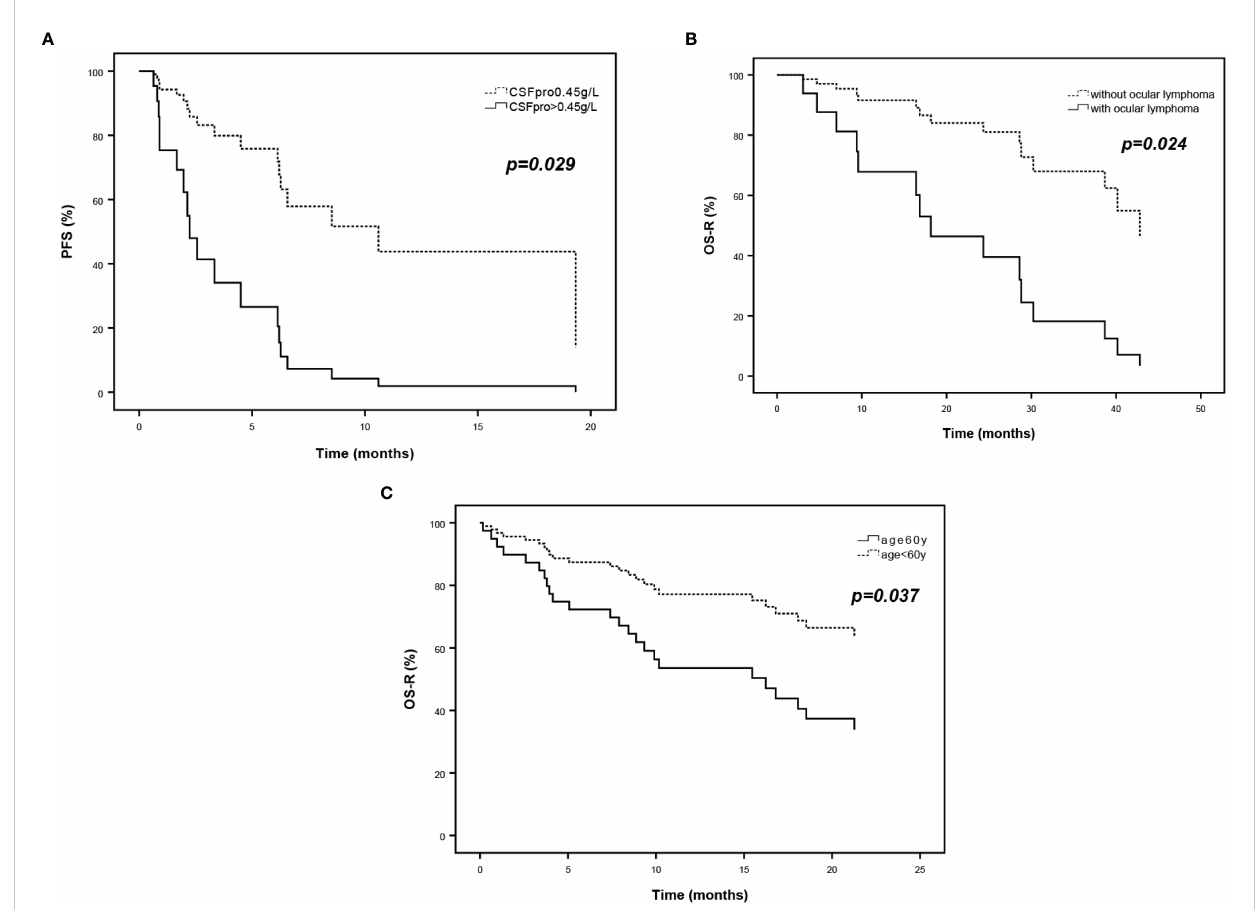
FIGURE 4 Survival curves of multivariate analysis of prognostic factors for relapsed and refractory PCNSL. (A) PFS curves according to CSF protein and (B) OS- R curves according to ocular lymphoma of relapsed PCNSL. (C) OS-R curves according to age at diagnosis of refractory